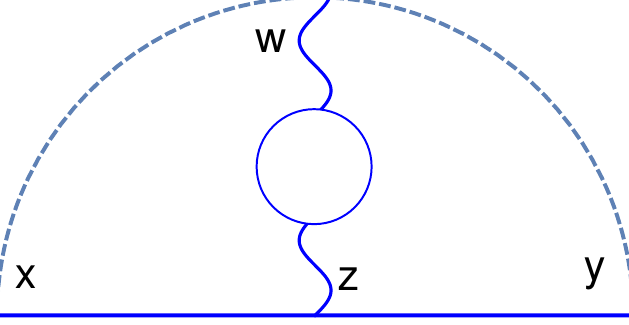
Figure 4 . Diagram for gauge link contribution with the propagator connecting one quantum gauge field in the medium and the other in the gauge link. The dashed semi-circle denotes the gauge link. The shear gradient enters through the photon self-energy. In LL approximation, only one insertion of the self-energy is